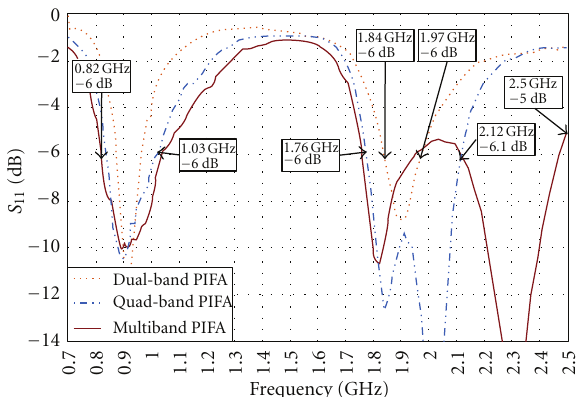
F 28: Measured total efficiency without the strip and with the strip considering loading inductors for the case shown in Figure